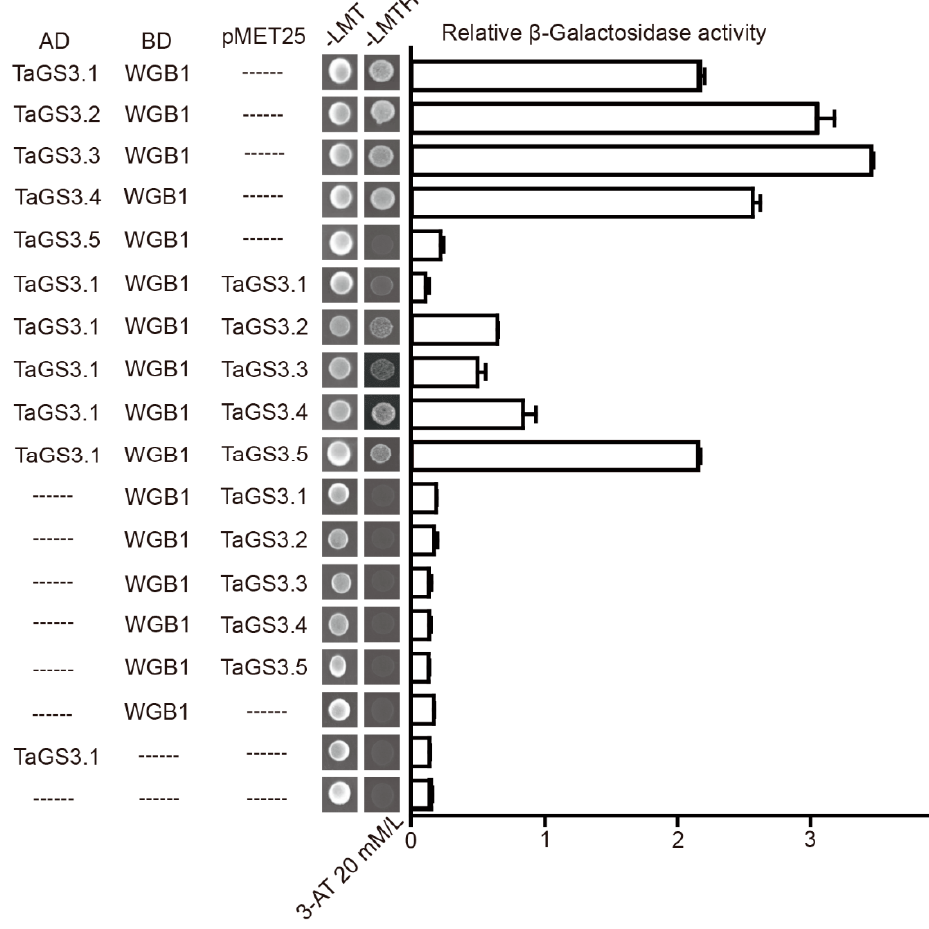
Figure 7. Competition test of the interactions between TaGS3 isoforms and WGB1. Yeast three-hybrid assay showing the competition between TaGS3.1 and the other four truncated TaGS3 isoforms to interact with WGB1 by using fusions with AD (AD-TaGS3 isoforms) and BD (BD-WGB1/BD-WGB1-GS3 isoform) (on the left). AD and BD represent empty pGADT7 and pBridge vectors, respectively. Empty vector was used as the negative control. -LMT, selective medium lacking Leu, Met, and Trp; -LMTH, selective medium lacking Leu, Met, Trp, and His. The specificity of the stringency of the assay was tested by adding 3-aminotriazole (3-AT, 20 mM/L). Quantitative analyses of interactions by β -galactosidase assay were shown (on the right) as mean ± SEM (n = 3).